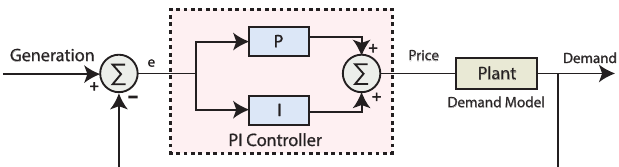
Figure 3. Block diagram of simulations using a proportional integral (PI) controller in closed-loop elastic demand control.